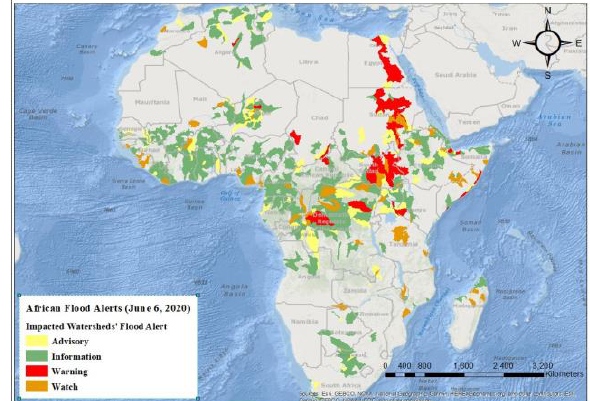
Figure 4: 2020220 VH binary classified image north of Lukolela. Common classifications are not removed in this image.